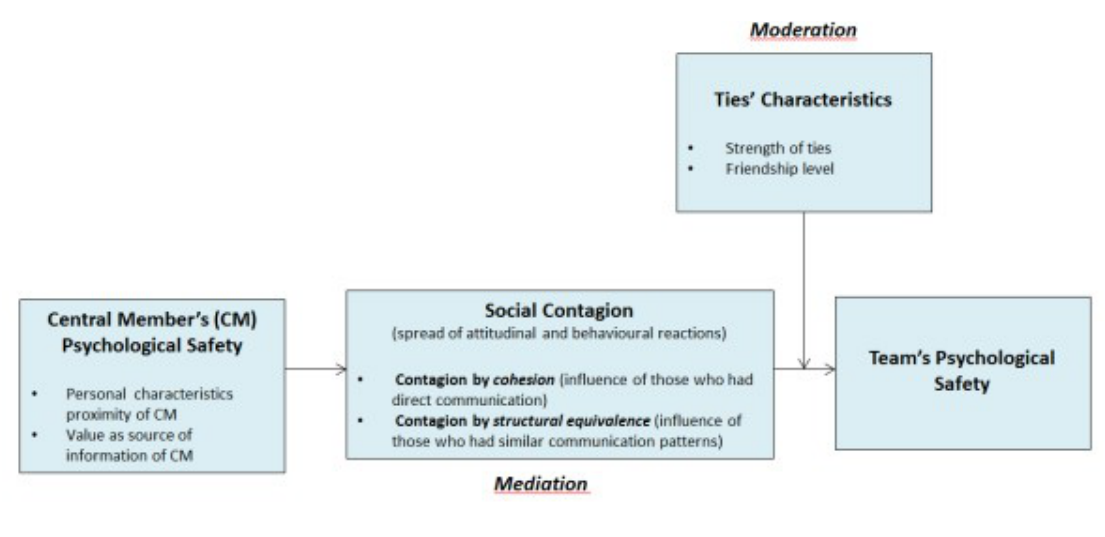
Figure 1. Model of the influence of social network on team psychological